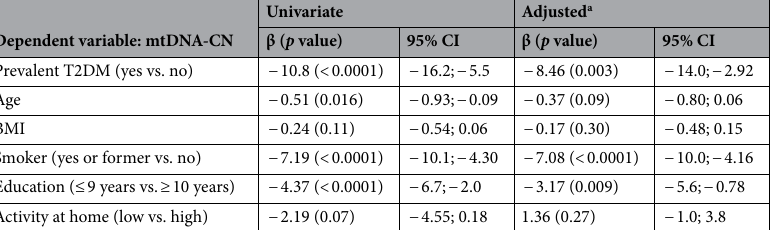
Table 5. Sensitivity analysis. Linear regression models examining effect of prevalent T2DM on mtDNA-CN after excluding pre-diabetic subjects based on IFG and IGT. a Adjusted for all variables (prevalent T2DM, age, bmi, smoking, education and physical activity). Cancer at or before baseline and pre-diabetics (n = 276) subjects based on IFG (impaired fasting glucose) and IGT (impaired glucose tolerance were